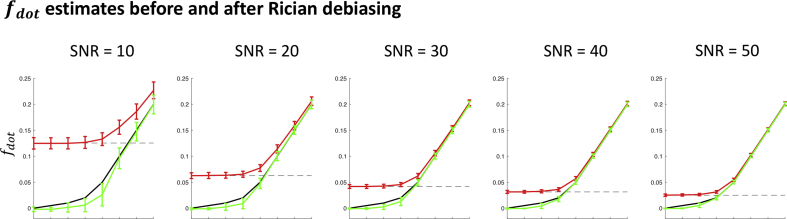
Simulated signal following Eq. [4] with different dot signal fractions (equidistantly spaced along the x-axis and connected by a line for improved visualisation, the true simulated dot signal fraction is represented by the black line and can be read from the y-axis) and different SNRs. Mean and standard deviation of the Rician signal and debiased signal are plotted in red and green respectively.